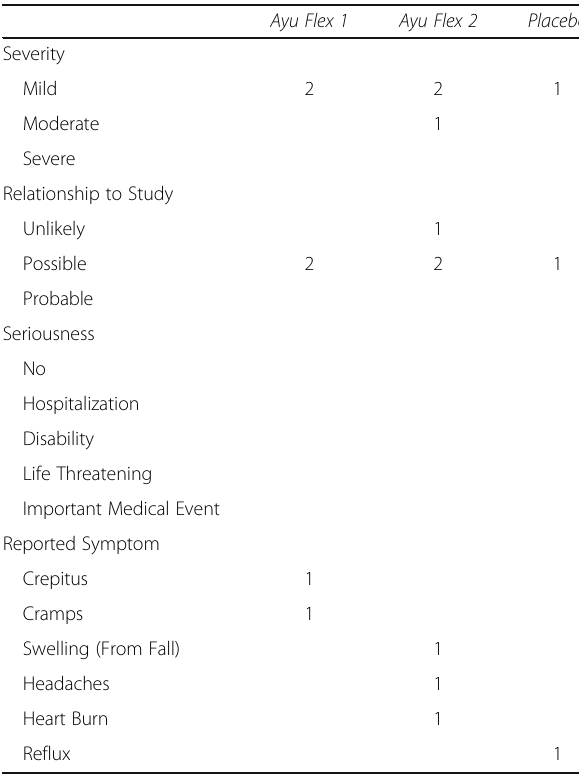
Table 12 Summary of adverse